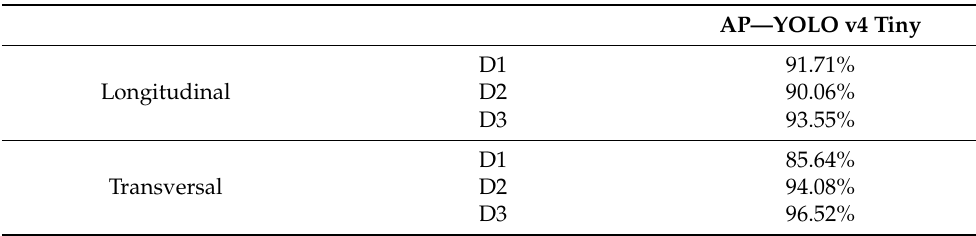
Table 5. K-fold performance in the identification of long and short axis view (i.e., longitudinal and transversal to the